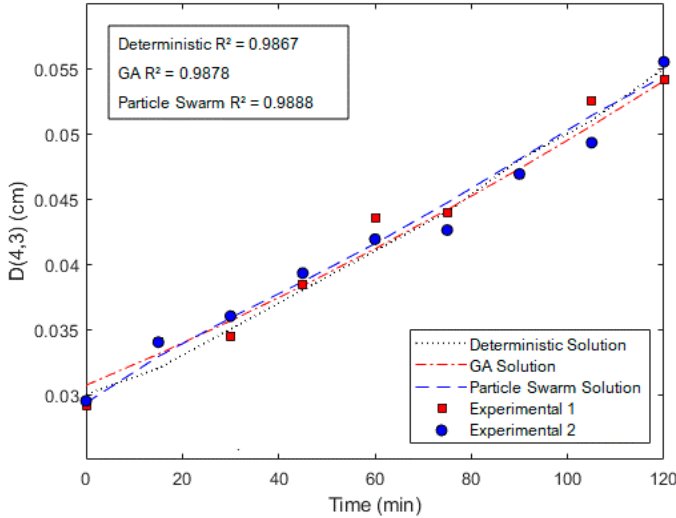
Figure 4. Model results—average crystal size D (4,3).